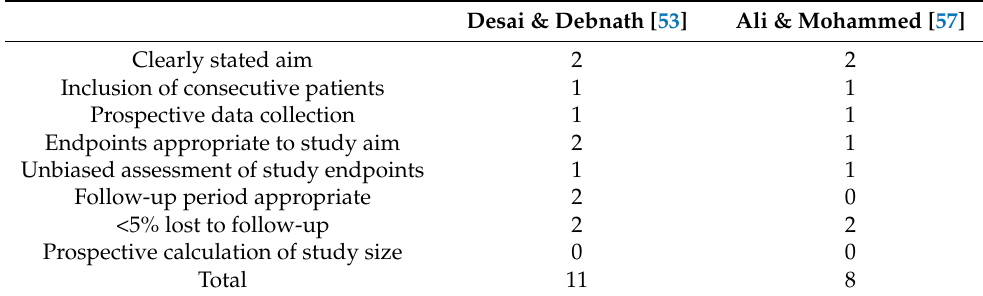
Figure 2. The ROB 2.0 tool was selected to evaluate the risk of bias of the included randomized clinical trials [41–50,52–54,56–62]. Table 2. Risk of bias assessment of non-randomized clinical trials using the Methodological Index for Non-Randomized Studies (MINORS) tool.